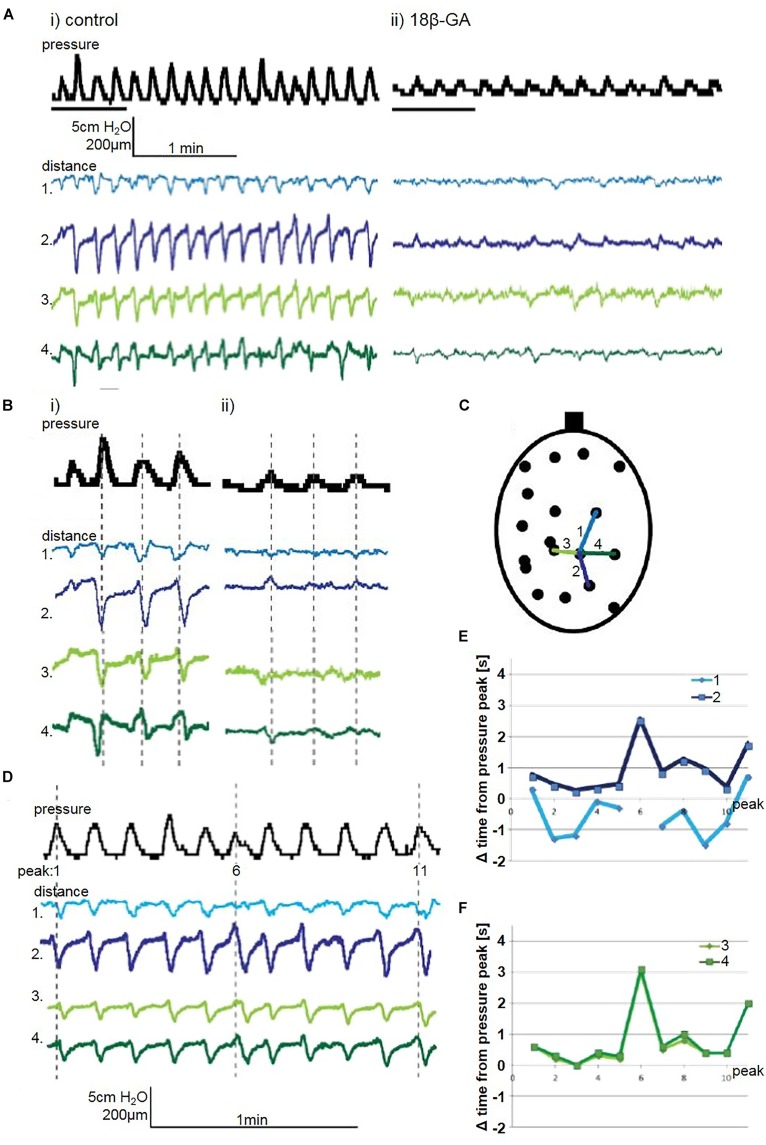
(A) A representative trace of spontaneous pressure fluctuations: (i) control and (ii) 18β-GA (30 μM), in an isolated whole rat bladder, and the effect on longitudinal (distances 1 and 2) and transverse (distance 3 and 4) components. (B) Enlargement of representative trace: (i) control and (ii) 18β-GA (30 μM), with grey dashed lines indicating the peak of pressure change, and relationship to distance change. (C) Schematic diagram depicting measured longitudinal and transverse distances. (D) A representative trace of spontaneous pressure fluctuations, and distances on the bladder wall with dominant longitudinal (distances 1 and 2) and transverse (distances 3 and 4). The offset of the distance shortening peak from the pressure fluctuation peak measured in seconds for (E) longitudinal and (F) transverse distances.